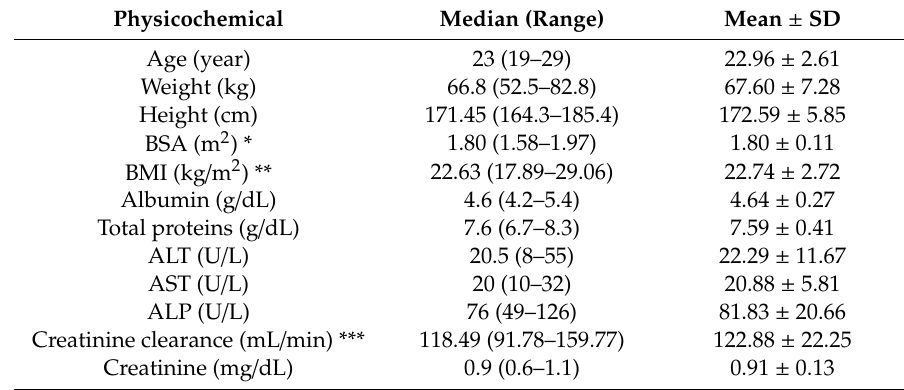
Table 1. Demographic information of the studied subjects ( n =